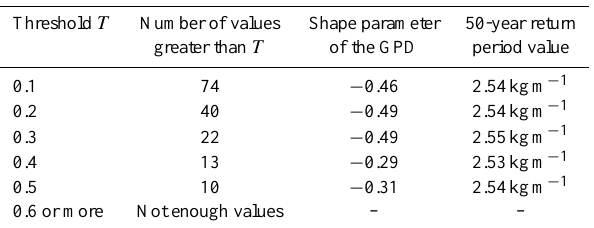
Table 3. Study of the 50-year return-period load for Lille in function of the threshold